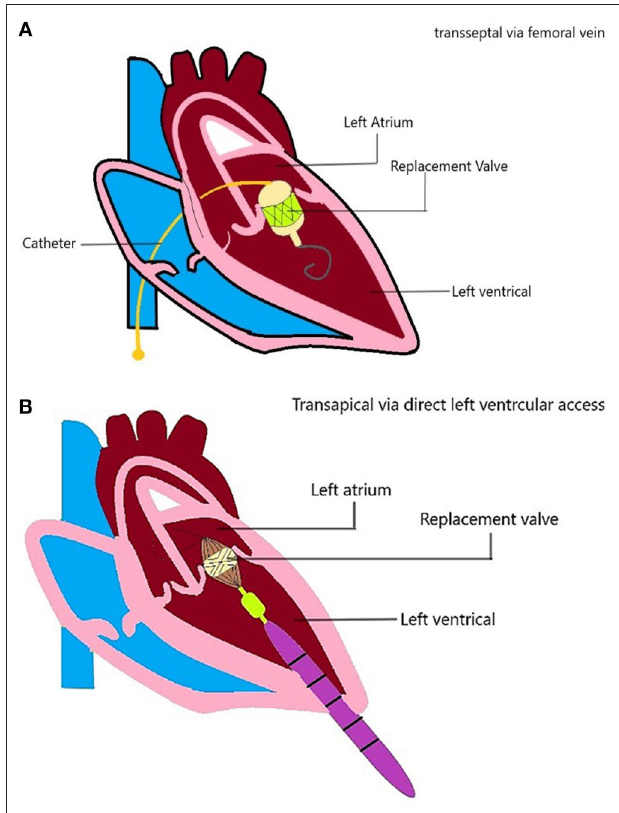
FIGURE 4 | TMVI device access. Schematic diagram showing the TMVI access (A) transseptal/transfemoral access, and (B) transapical access of